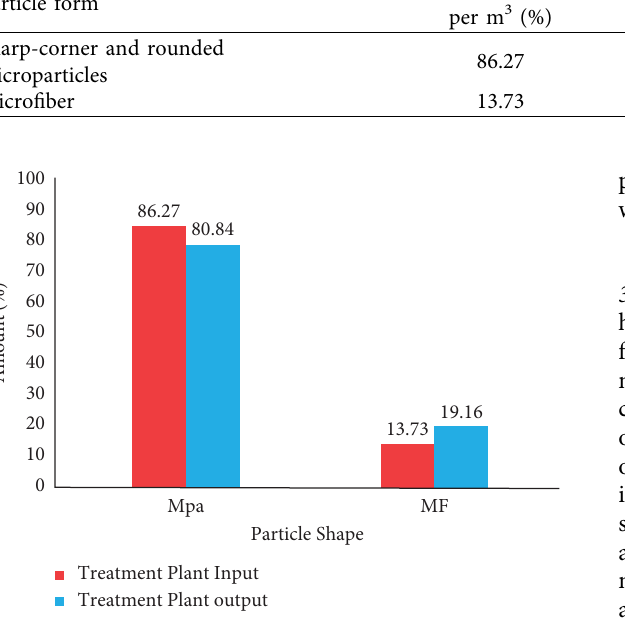
Figure 9: Te amount of particles in the incoming and outgoing